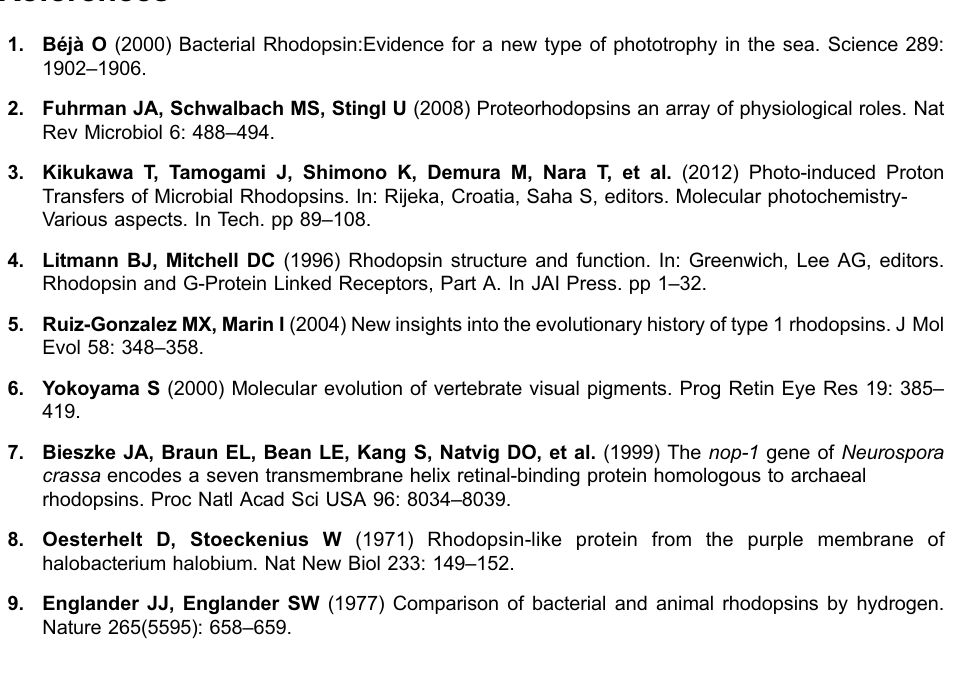
S1 Table. Alignment of PR and SR types of O. marina rhodopsin to indicate similarity and difference. Asterisks depict identical amino acid residues; dots depict positions where residues are chemically similar, with positions dominated by one residue indicated by double dots. In yellow shade are regions conserved in the PR type but absent in the SR type. In red letters are residues that compose retinal pocket, which are all conserved in the PR type but partially different in the SR type. Triangle indicates position where proton donor (green) and receiver (blue) are expected, which are also conserved in the PR type but not so conserved in the SR